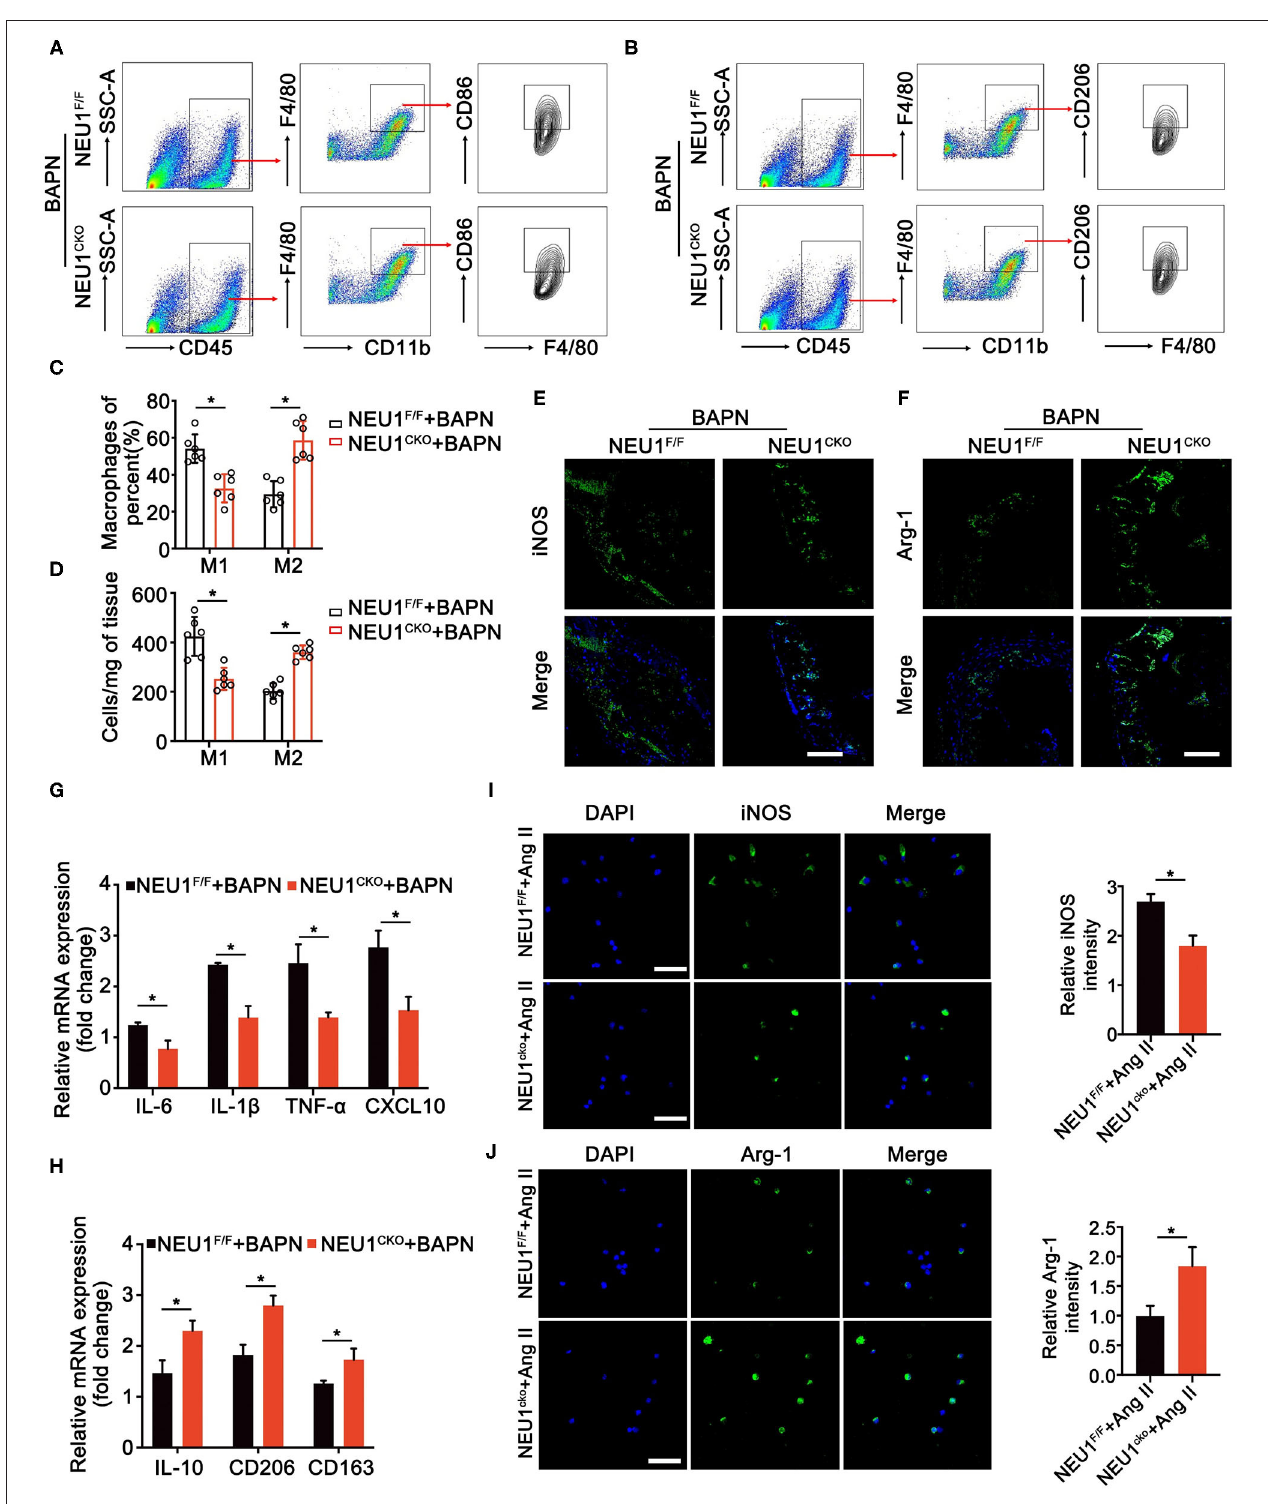
FIGURE 5 | NEU1 deletion promotes the polarization of macrophages. (A,B) Gating strategy for CD45 + CD11b + F4/80 + CD86 + M1 macrophages and CD45 + CD11b + F4/80 + CD206 + M2 macrophages in aortas of NEU1 CKO mice and their controls. (C,D) Quantification of the CD86 + and CD206 + macrophages. (E,F) Immunofluorescence images of iNOS + and Arg-1 + macrophages in aortas of NEU1 F / F and NEU1 CKO mice subjected to BAPN induction for 4 weeks (scale bar: 50 µ m). (G,H) mRNA levels of M1 and M2 markers in macrophages sorted by flow cytometry of NEU1 F / F and NEU1 CKO mice subjected to BAPN induction for